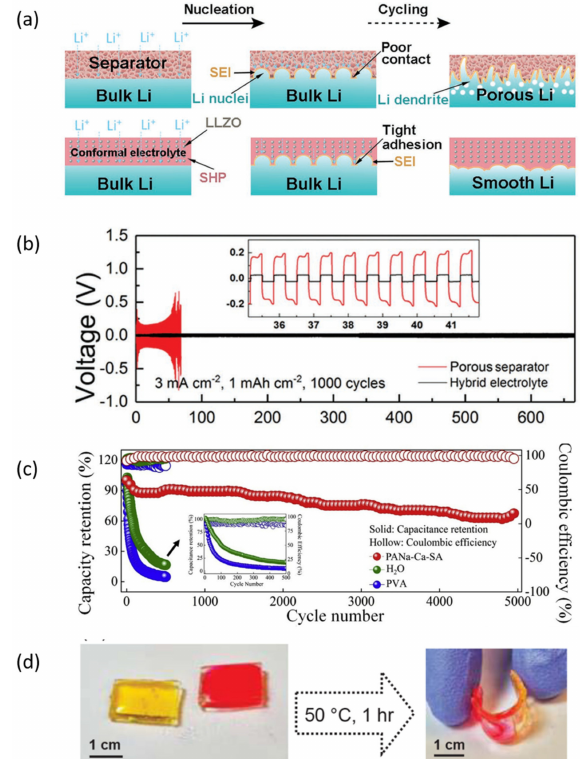
Figure 6. Self-healing gel polymer electrolytes in LIBs. ( a ) schematics of Li stripping/plating situation with porous separator and hybrid electrolyte, and ( b ) voltage–time profiles of the symmetric cell over long cycles using porous separator and hybrid electrolyte [84]. Copyright 2019, John Wiley and Sons; ( c ) the long cycle performances of ALIYB vs. PVA electrolyte and aqueous solution [85]. Copyright 2020, Elsevier Ltd; ( d ) photographs showing the self-healing of a rectangular bar-shaped gel initially cut into two pieces, each dyed a different color, and then heated at 50 ◦ C for 1 h [86]. Copyright 2019, American Chemical